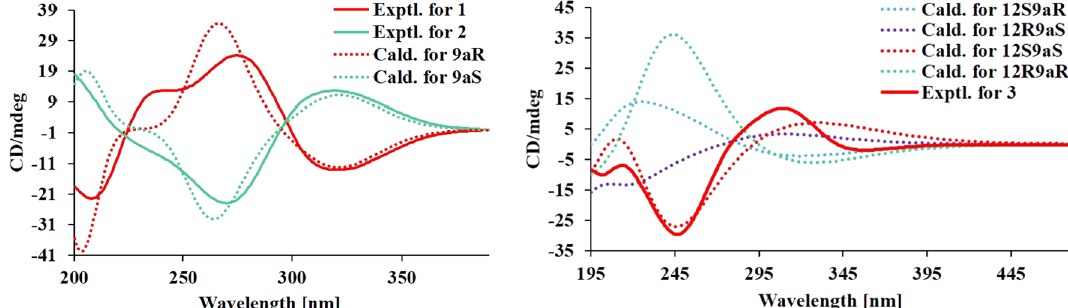
Fig. 4 Experimental and calculated ECD curves of alkaloids 1 –